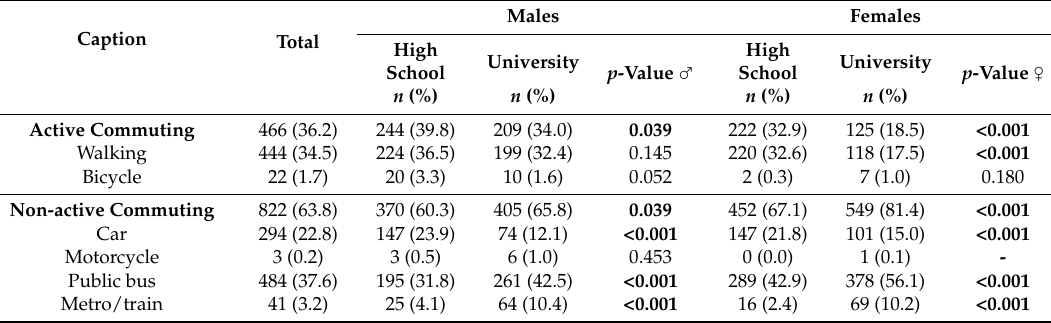
Table 2. Commuting mode that students use from their home to school and